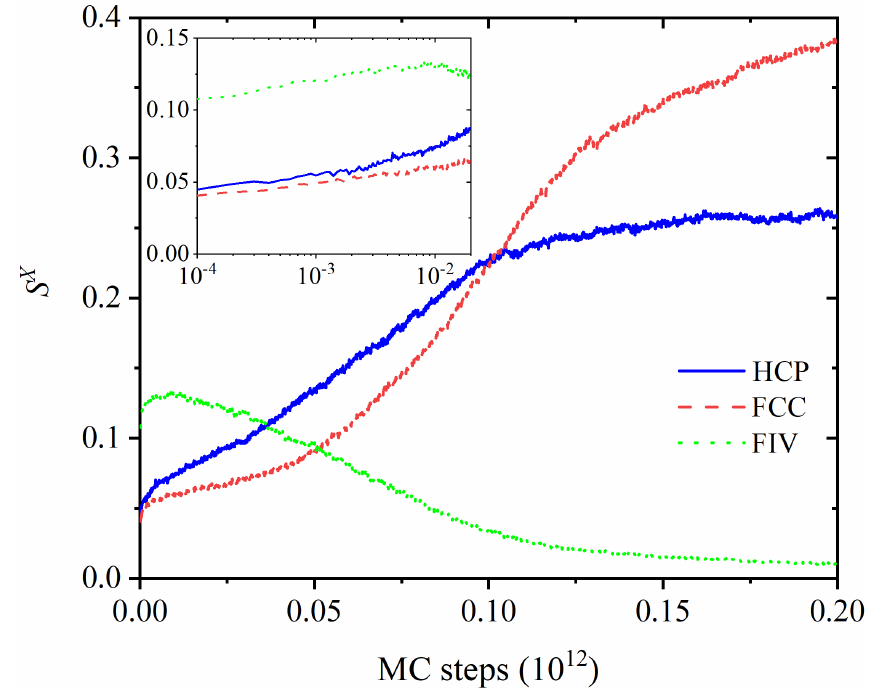
Figure 2. Early evolution of site fractions S X , X ∈ [ HCP, FCC, FIV ] in the first 2000 frames (2 × 10 11 MC steps). Inset: zoom on the first 200 frames (2 × 10 10 MC steps) in log-linear scale.